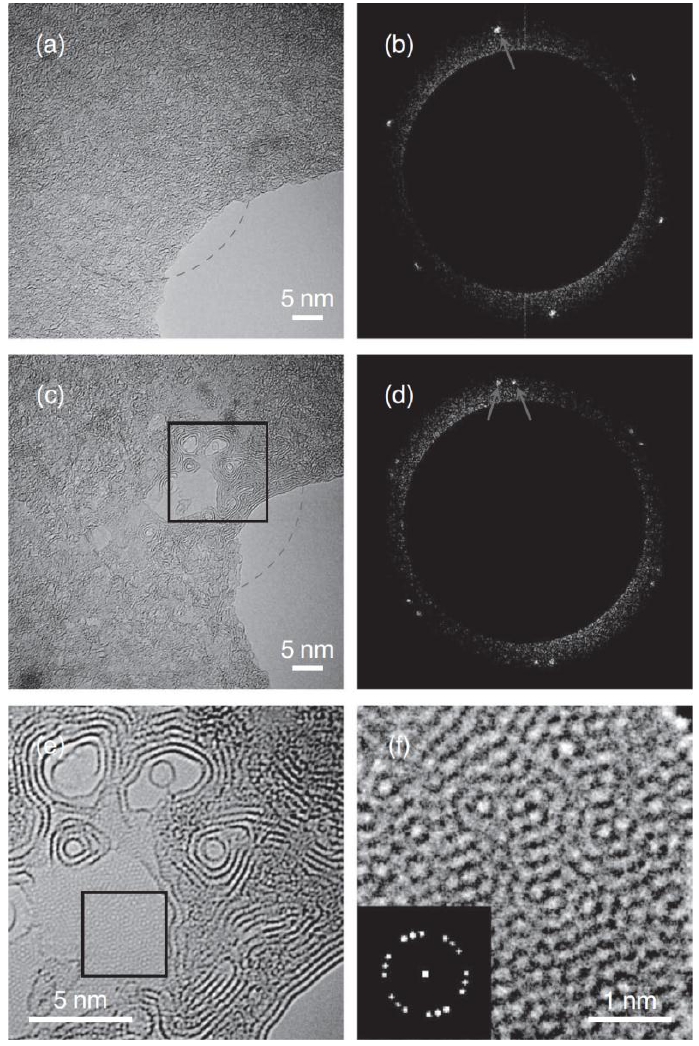
Figure 3. Catalyst-free fabrication of graphene from amorphous carbon supported on graphene. ( a ) Pristine sample of amorphous carbon residing on a single graphene layer. The dashed ring indicates the area to be irradiated. ( b ) The Fourier transform from micrograph shown in panel (a)—six spots from the underlying single layer graphene support are visible. ( c ) The sample shown in panel (a) after 12 min irradiation. ( d ) The Fourier transform from micrograph (c)—An additional set of spots as compared to before irradiation (see panel (b)) have now appeared confirming new graphene has formed on the graphene support. ( e ) Magnified section from (b) showing terrace steps of the grown planar few-layer graphene. ( f ) Further magnified section from (e) showing Moiré patterns of the newly formed few-layer graphene. Inset: corresponding Fourier transform indicating three different rotations from rotational sticking faults between the graphene layers. Reproduced with permission. Ref. [34] Copyright (2012), John Wiley and Sons.